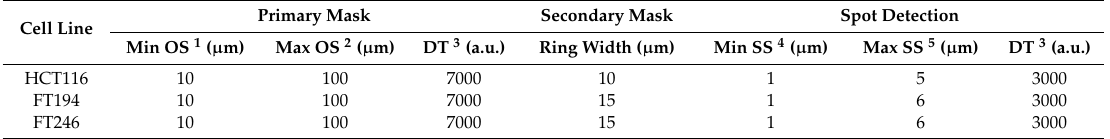
Table 1. Optimized image thresholds and filters employed for the HCT116, FT194, and FT246 cells. Primary Cell Line